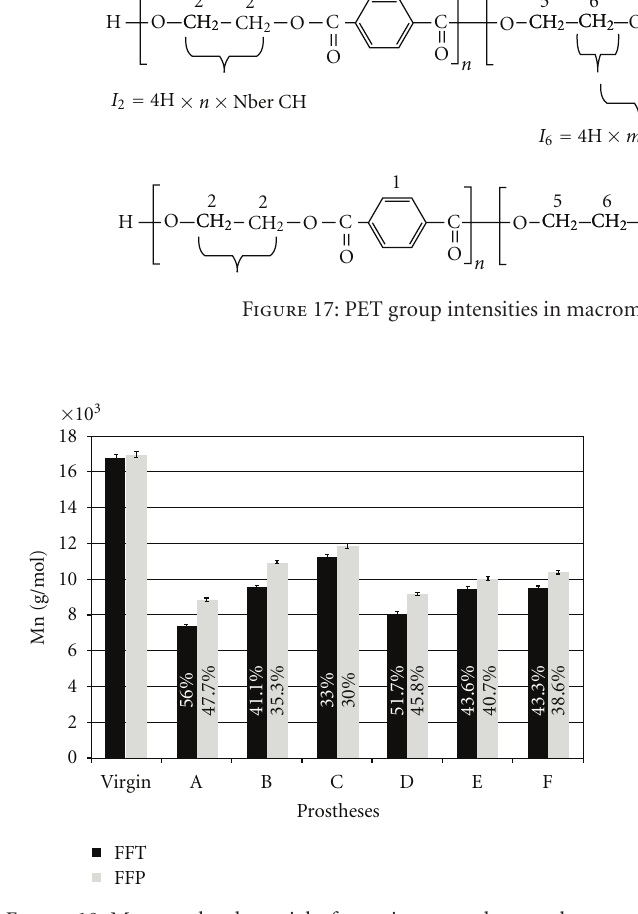
Figure 18: Macromolecular weight for various vascular prostheses using 1H-NMR